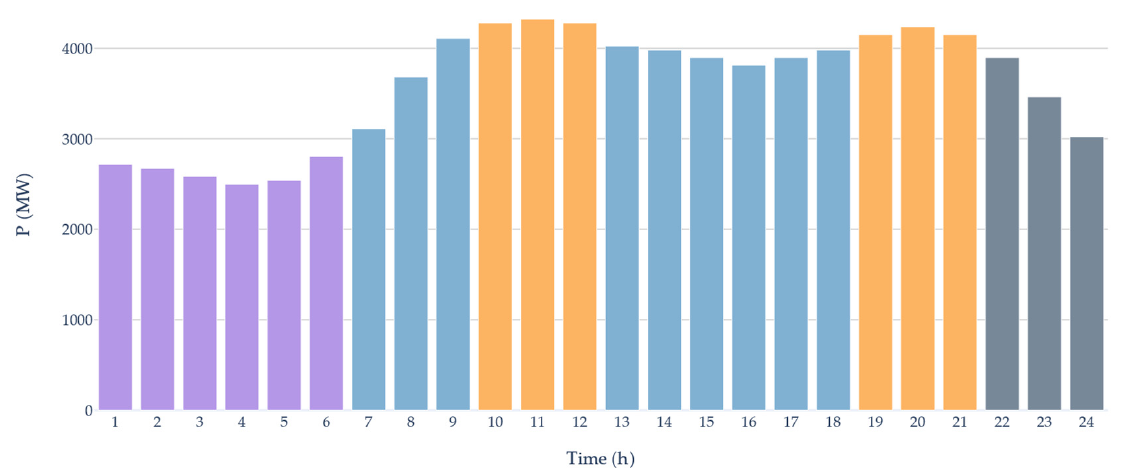
Figure 1. The 24 h load curve performed on the IEEE 118-bus test system.